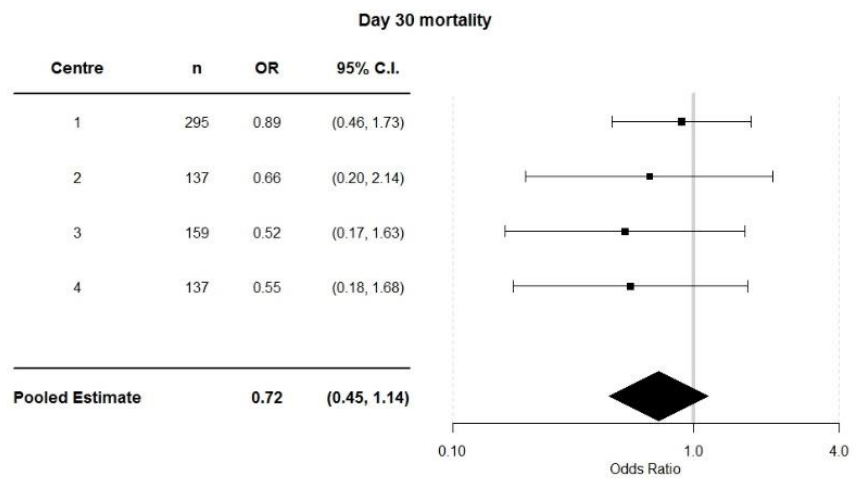
Figure 5. Incidence of 30-day mortality.